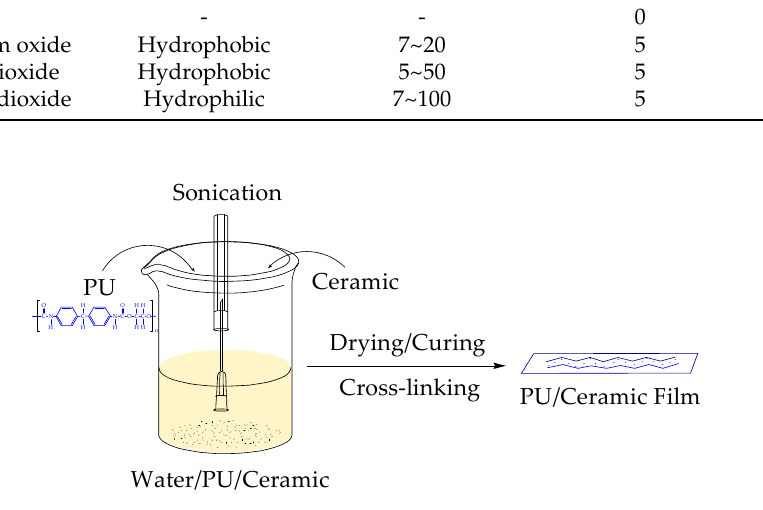
Figure 1. Sample preparation scheme for polyurethane composites with different ceramics.